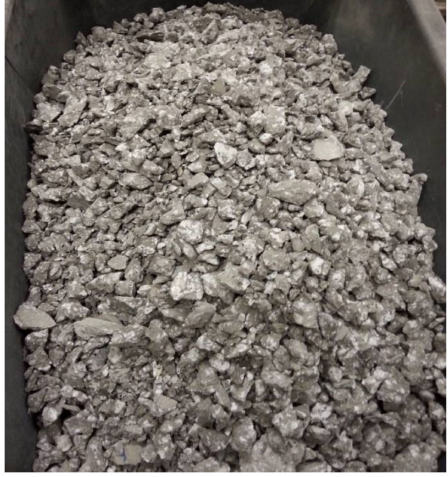
Figure 1. Coarse recycled concrete aggregate.